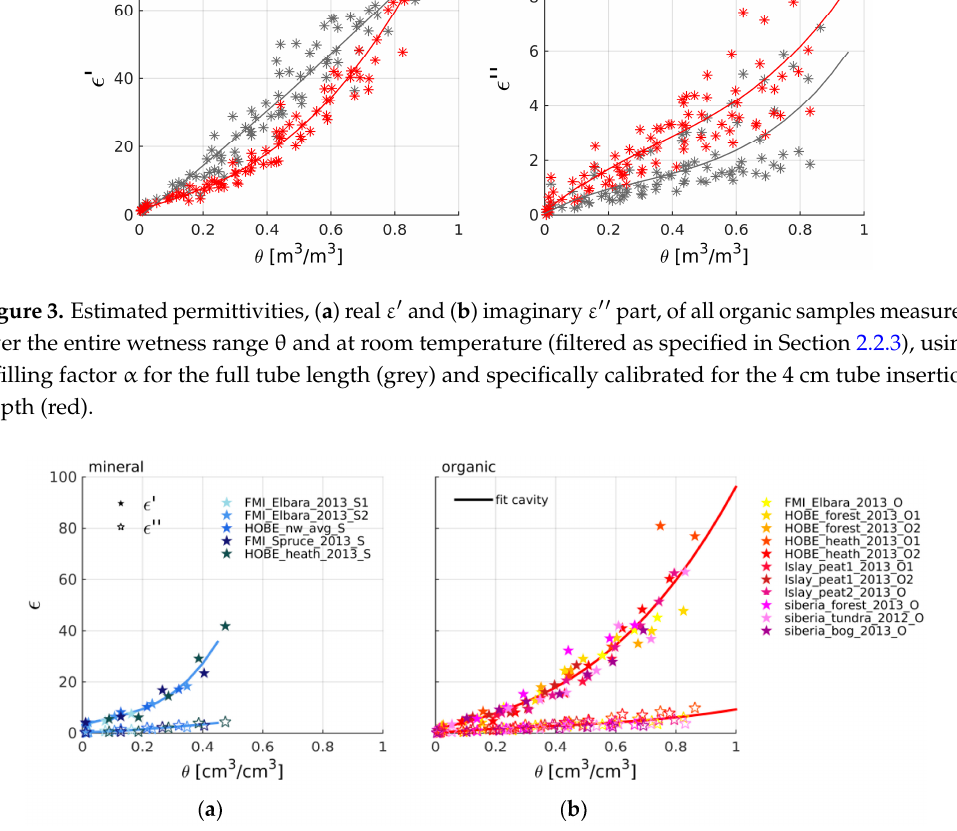
Figure 4. Average resonant cavity relative permittivity ε measurements (filled and empty stars for real ε′ and imaginary ε″ part, respectively) over the entire wetness range θ , at room temperature, for the ( a ) individual mineral and ( b ) organic samples. Simple empirical models fit through the cavity datasets of all organic and mineral samples (for ε′ and ε″ , respectively) are plotted along (solid line). Table 3. Coefficients of the simple model for organic substrates and for sandy mineral soils, respectively: third order polynomial functions through the water content—relative permittivity (real ε′ and imaginary ε″ part) couples of all available organic/mineral samples (see Table 1) measured by means of the resonant cavity method, with fit_organic(x)/fit_mineral(x) = c1* × ^3 + c2* × ^2 + c3* × + c4. Type c1